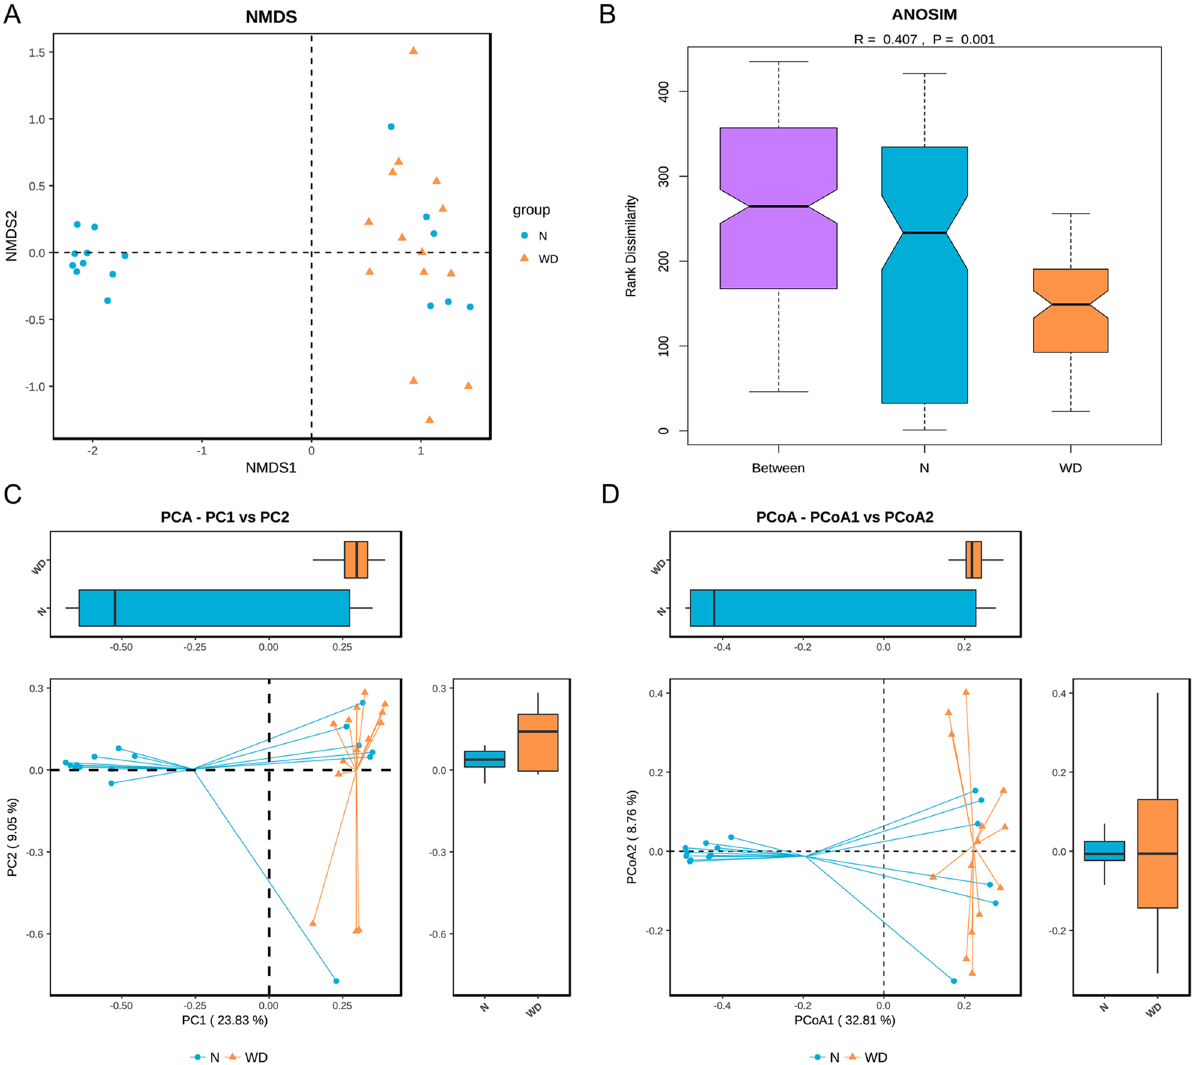
Figure. 5. Comparison of the beta diversity of the gut microbiota between two groups. ( A ) Non-metric multi- dimensional scaling, ( B ) analysis of similarities (ANOSIM, R = 0.407, P = 0.001), ( C ) principal component analysis (PC1 23.83% vs. PC2 9.05%), and ( D ) principal coordinates analysis (PCoA1 32.81% vs. PCoA2 8.76%) illustrating the grouping patterns of the WD group and control group based on the Bray–Curtis and unweighted UniFrac distances. Each dot represents a sample, and the corresponding group can be found in the legend. Distances between any pair of samples represent the dissimilarities between each sample. There was a significant difference in β-diversity between the two